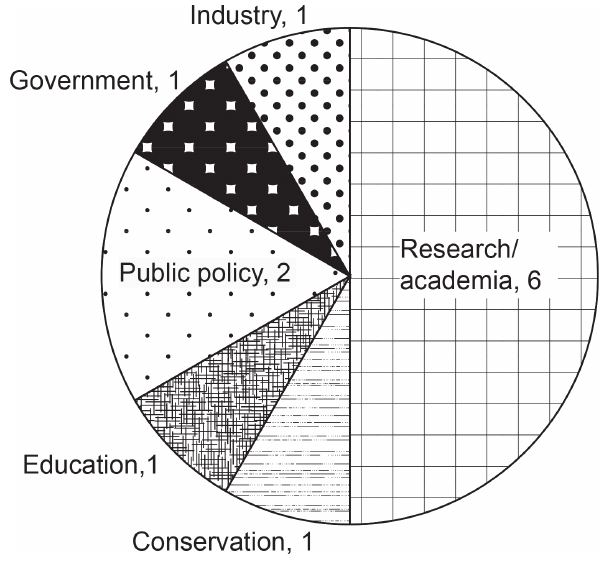
Figure 4. Preferred career paths and the number of students that reported those preferences in this